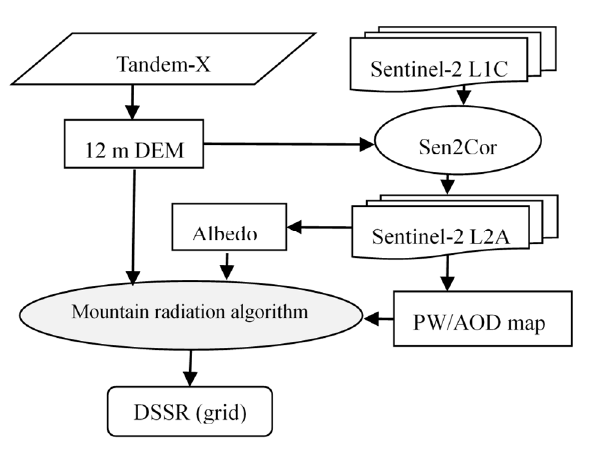
Figure 2. Flowchart of the integrated algorithm.